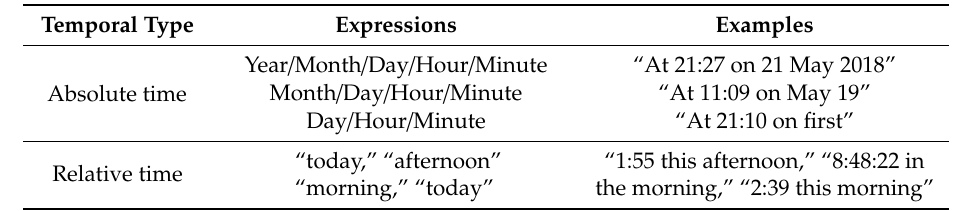
Table 1. Temporal expression dictionary.